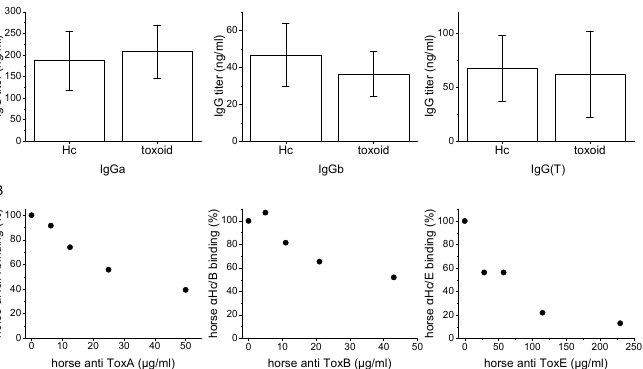
Figure 4. Characterization of subunit-derived antitoxin. ( A ) IgG subclass levels in the plasma of Hc- and toxoid-immunized horses. Plasma samples were serially diluted from 1000 to 15.6 ng/mL of total IgG, adsorbed to 96-well plates, and detected by a subclass-specific antibody as indicated. The lowest IgG concentration that induced a signal in each sample is indicated. The results are the average ± STD for each indicated group (Hc/A, H C /B, and H C /E or toxoid A, B, and E). The difference in IgG subclass frequency between Hc fragment-vaccinated horses and toxoid-vaccinated horses was not significant (P value of 0.52, 0.15 and 0.78 for IgGa, IgGb, and IgG(T), respectively). ( B ) Competitive binding of SDAs and TDAs. Serial dilutions of the indicated horse anti-toxoid IgG samples were incubated with a constant concentration of HRP-conjugated horse anti-Hc, and the mixtures were allowed to bind toxoid-coated plates. The absorbance results were normalized to the absorbance obtained in control wells in which naïve horse antibody at the lowest dilution used for the corresponding horse anti-toxoid antibody was incubated with HRP-conjugated horse anti-Hc fragment. For all BoNT serotypes, increasing the horse anti-toxoid IgG concentration resulted in reduced binding of horse anti-Hc, indicating that both preparations bind mutual epitopes on the toxoids.